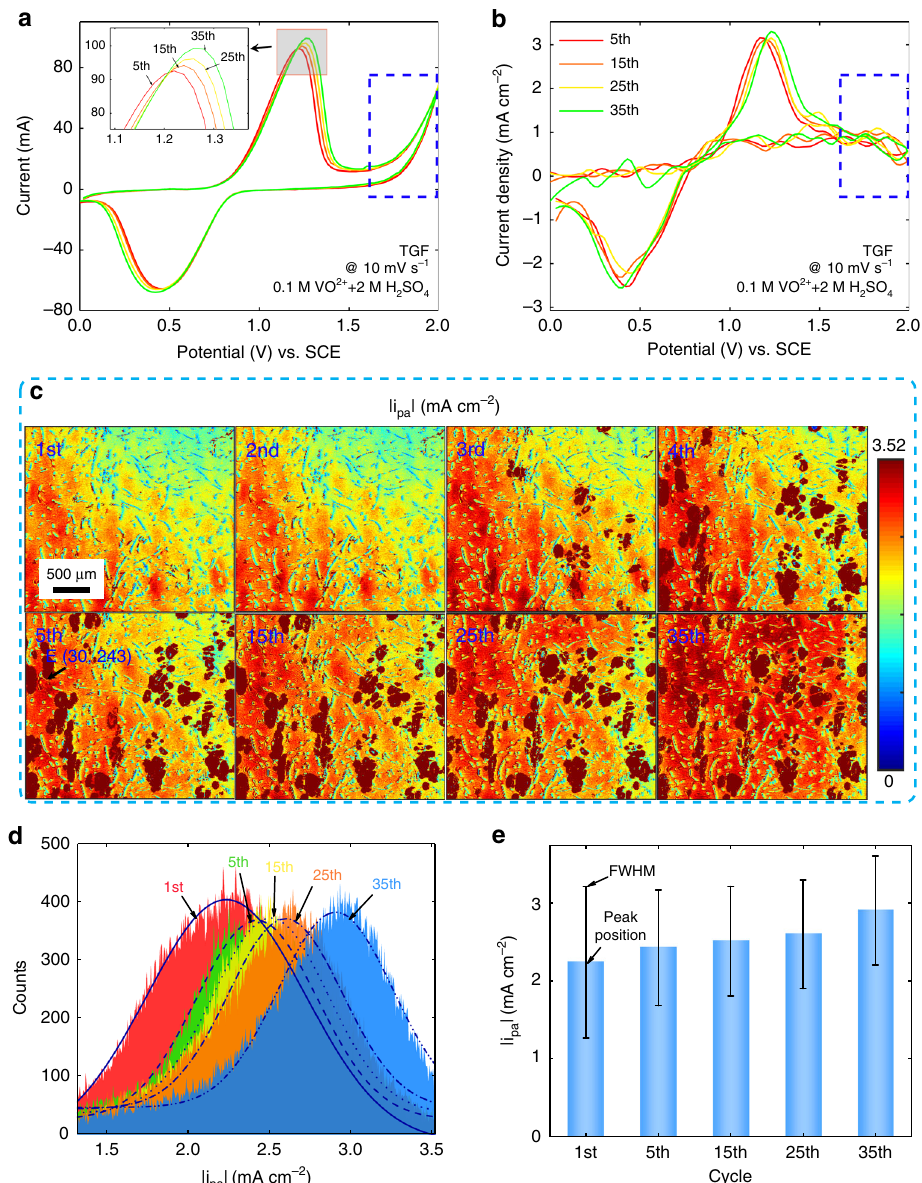
Fig. 5 Activity distribution of thermal-activated graphite felt (TGF) in long-term cyclic voltammetry (CV). a Long-term CV curves (5th, 15th, 25th, 35th cycle) of the TGF in the positive electrolyte of 0.1 M VO 2 + and 2 M H 2 SO 4 at a scan rate of 10 mV s − 1 recorded by EW. b Long-term CV curves of point E (30, 243) by convolution calculation of intensity variations recorded by the TIRi sensor. The mappings of the peak oxidation current densities | i pa | ( c ), | i pa | distribution ( d ) and the peak position and FWHM comparison of | i pa | ( e ) for the TGF in different